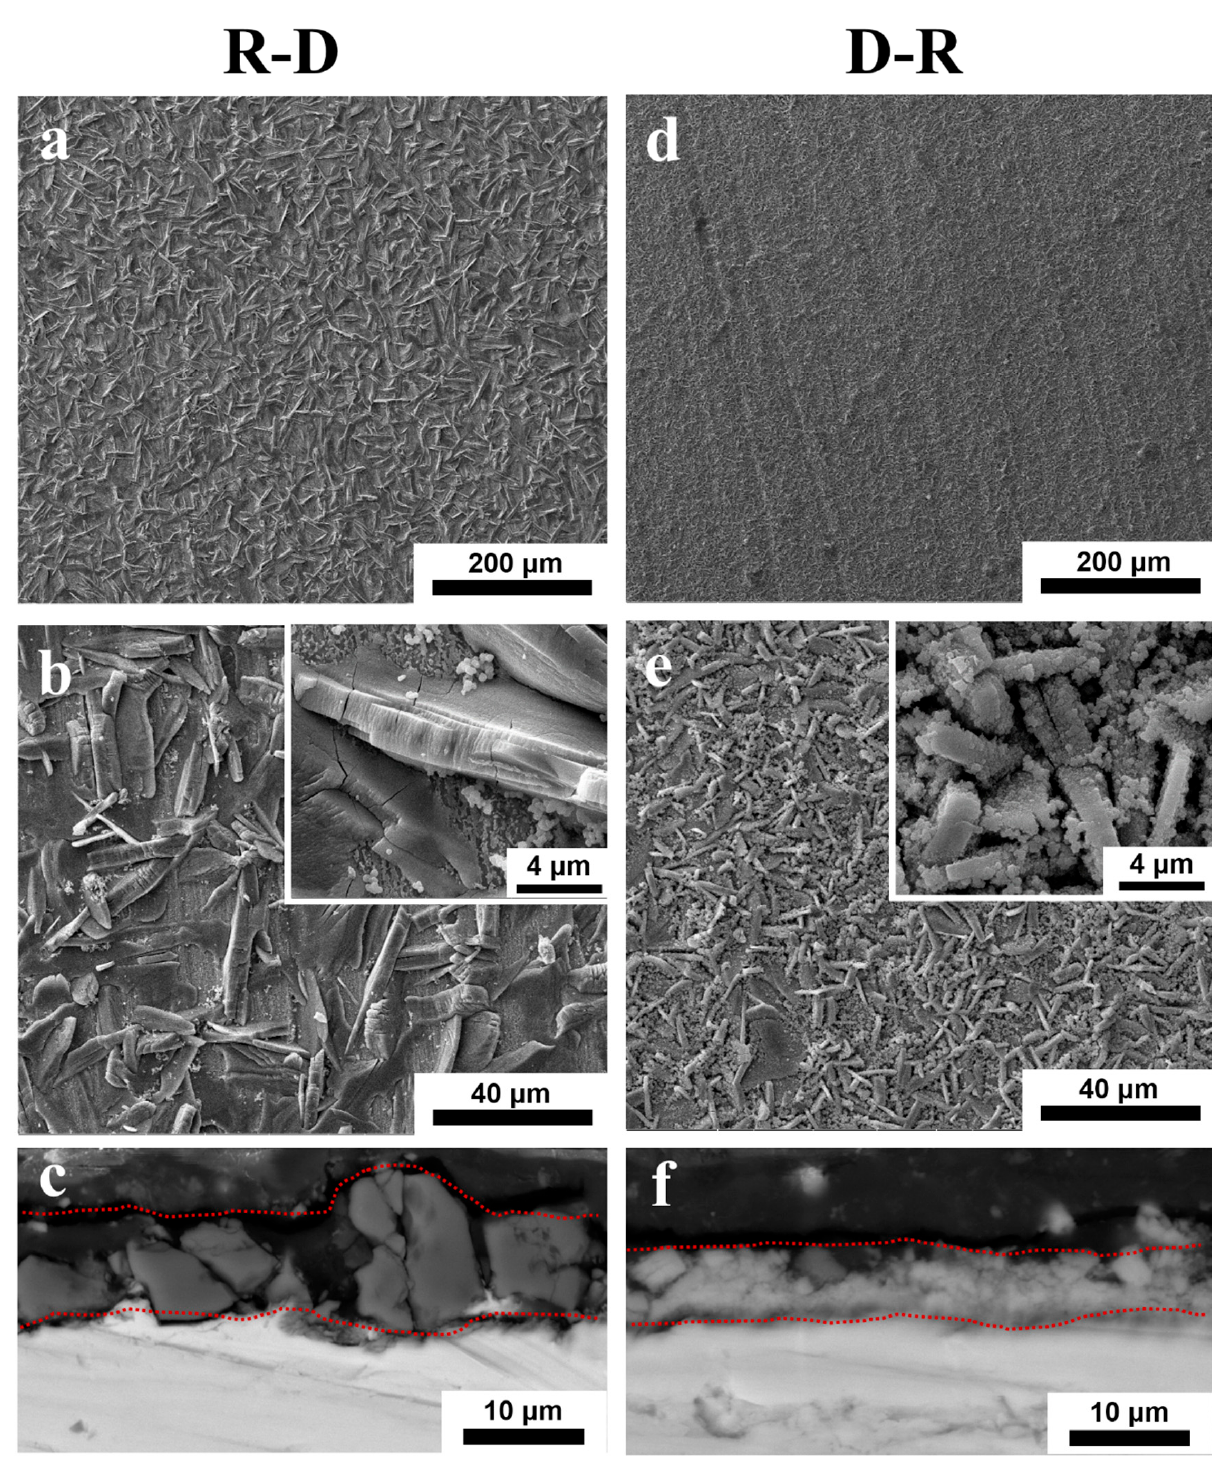
Figure 2. SEM micrographs of the surface of ( a ) R-D and ( d ) D-R samples. ( b , e ) are their corresponding images at high magnification. ( c , f ) are their corresponding cross-sectional images.